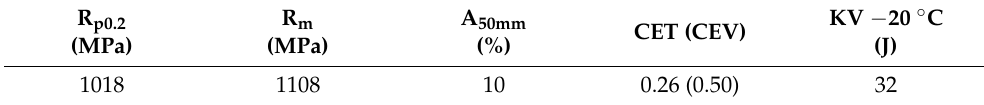
Table 1. Mechanical properties of Strenx 960MC according to the inspection certificate.